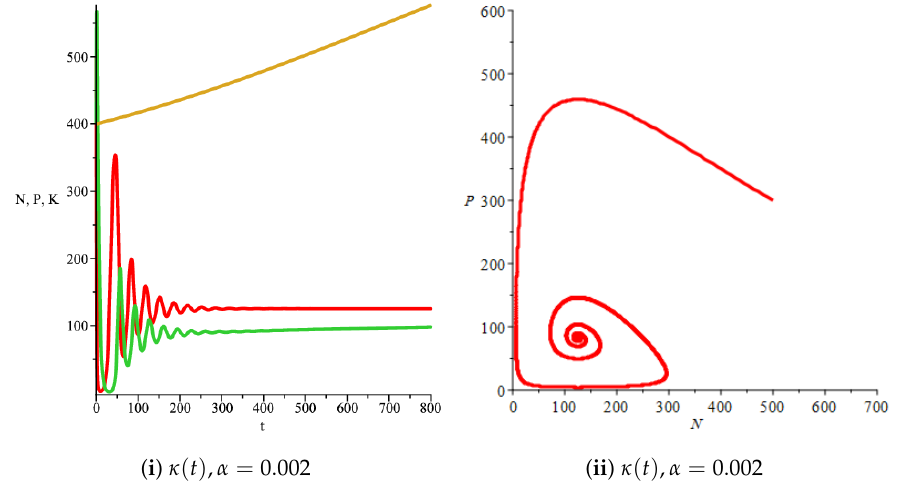
Figure 7. Effect of logistic carrying capacity on prey–predator model with Holling type II functional response, κ 1 = 300, κ 2 = 500, r = c = 0.25, a = b = 0.0025, γ = 0.002.